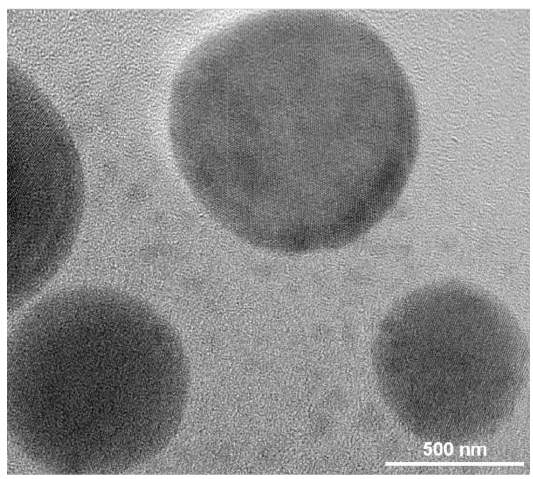
Figure 4. The transmission electron microscopy (TEM) image of the extracted Cu NPs from the Cu/Ag/PDA/PET fabric.